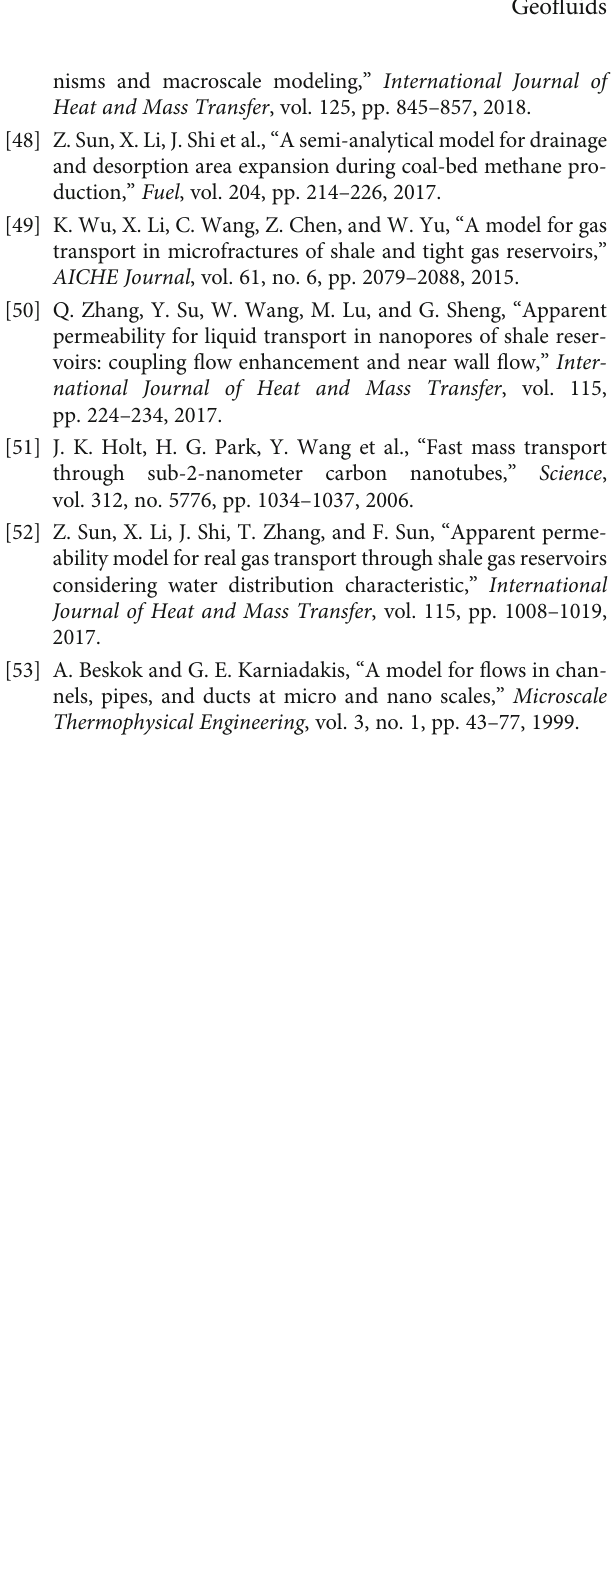
tability on liquid density, structure, and di ff usion near a solid cle 034707,